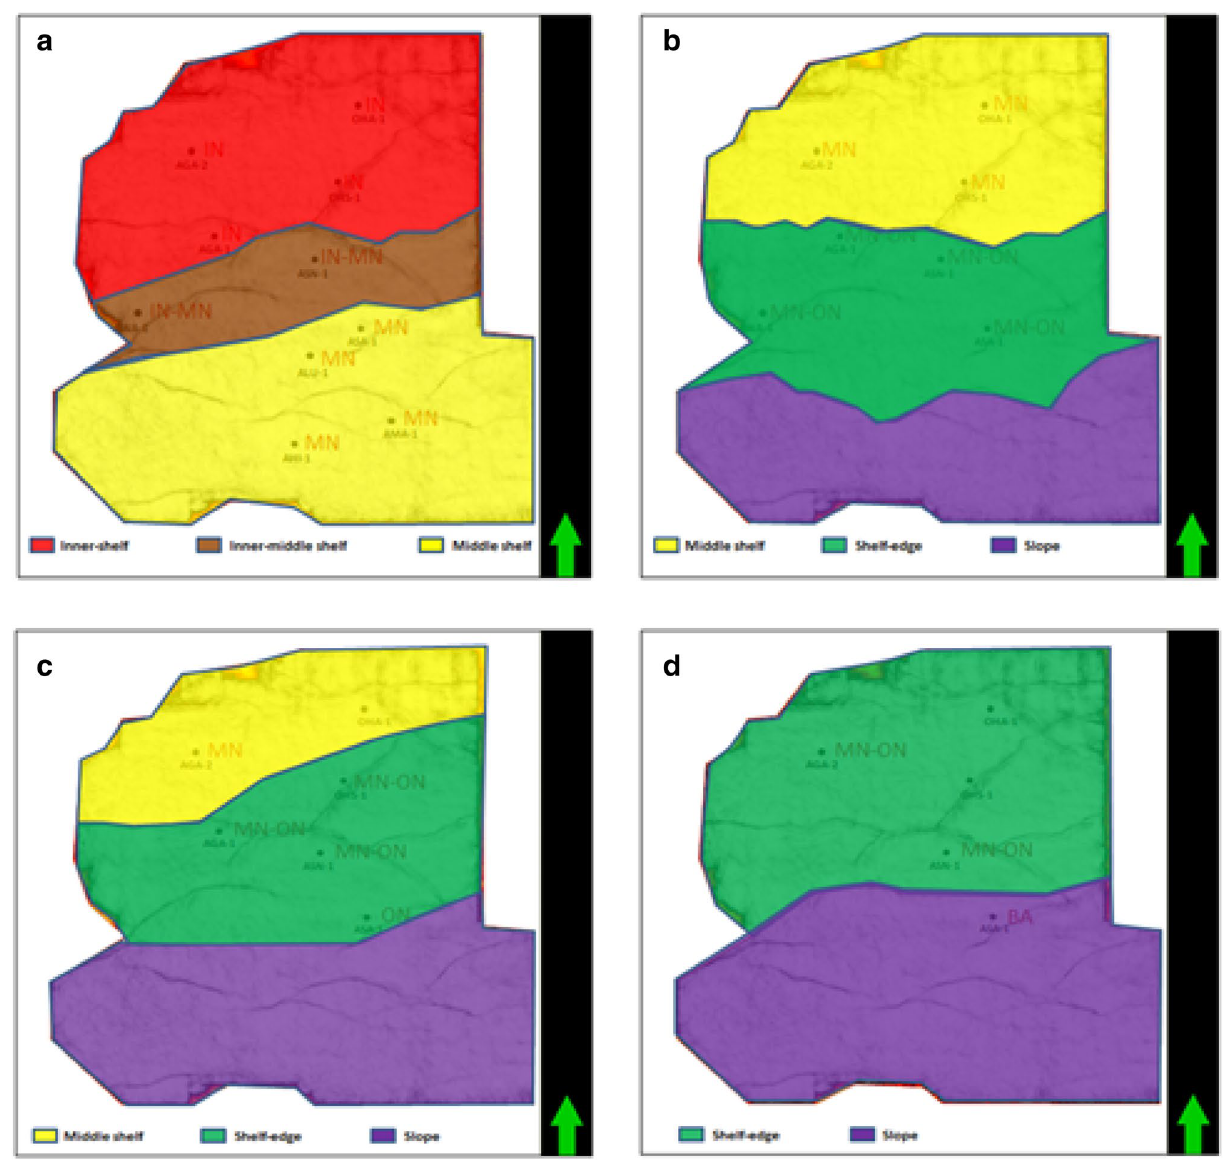
Fig. 9 Resultant gross depositional environment maps from a MFS 26.2 to 28.1, b MFS 28.1 to 31.3, c MFS 31.3 to 33.0 and d MFS 33.0 to